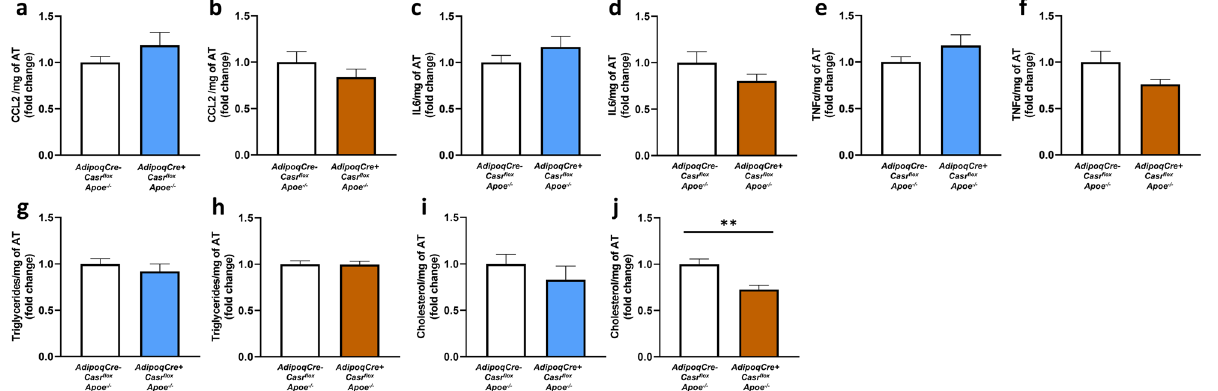
Figure 3. CaSR in adipocytes does not interfere with vAT inflammation in-vivo. ( a – f ) Inflammatory cytokines CCL2 ( a , b ), IL6 ( c , d ) and TNF-α ( e , f ) were measured in vAT isolated from AdipoqCre− Casr flox Apoe −/− and AdipoqCre + Casr flox Apoe −/− after 4 (blue; a , c , e ; n = 10–14) and 12 weeks (orange; b , d , f ; n = 8–11) of HFD. ( g–j ) triglycerides ( g , h ) and cholesterol ( i , j ) in vAT from the mice were measured after 4 (blue; g , i ; n = 10–15) and 12 weeks (orange; h , j ; n = 10–11) of HFD. Bar graphs are representation of mean ± SEM. **p <